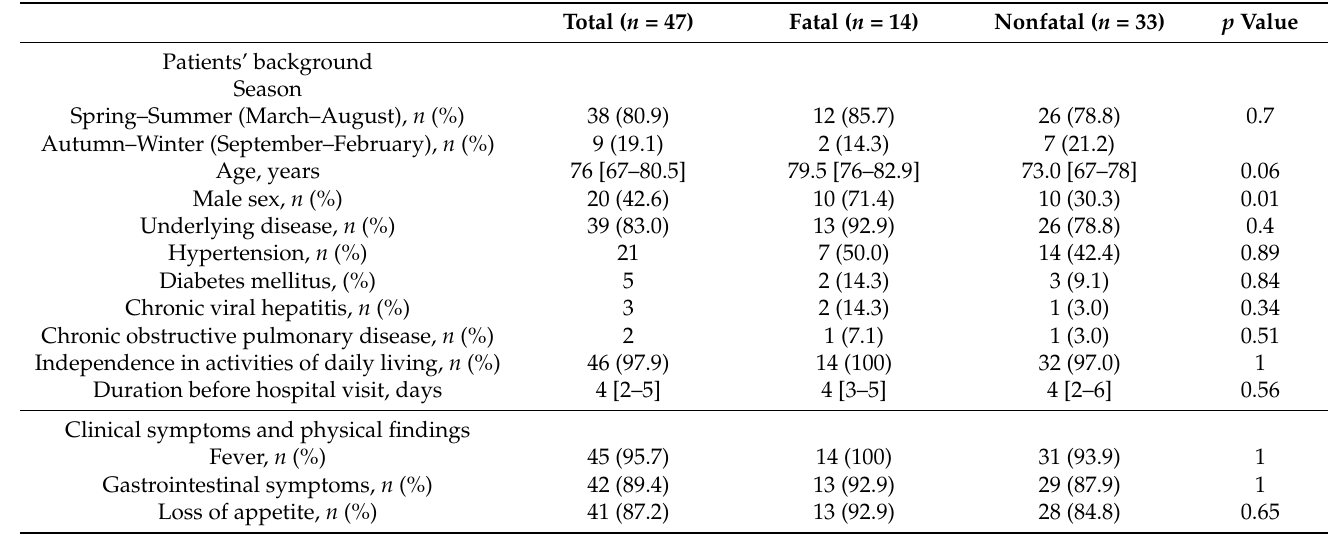
Table 1. Clinical characteristics of the